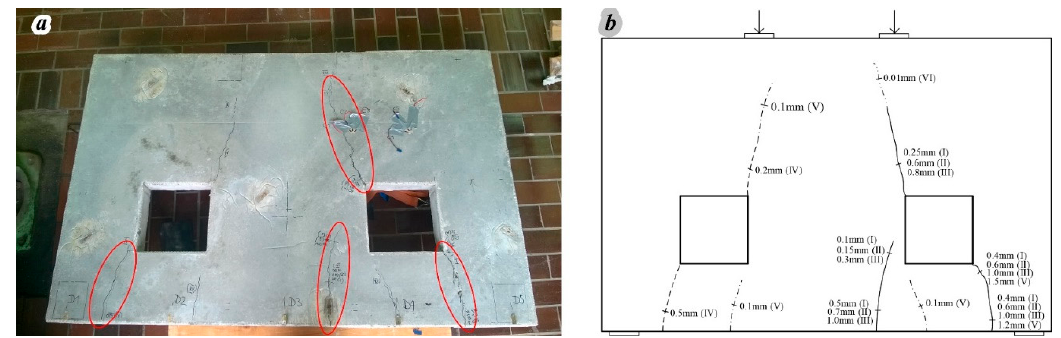
Figure 21. Crack and failure pattern: ( a ) tested member W3 at maximum load, ( b ) schematic view.